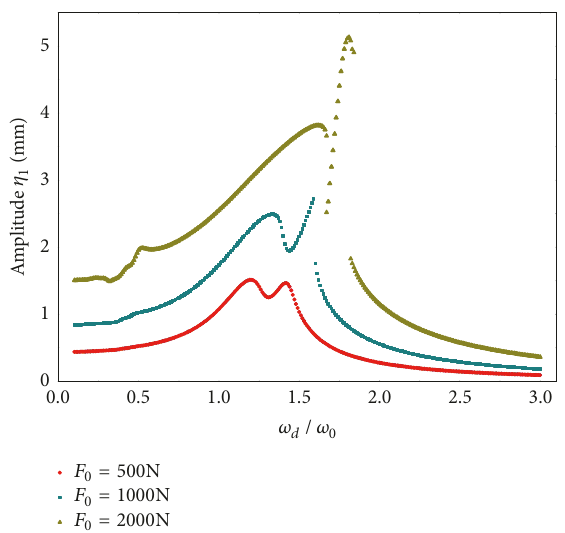
Figure 8: Amplitude-frequency curves related to 𝜂 1 for different excitation amplitudes ( 𝑚 = 1 , 𝑛 = 4 ; Ω = 0.005 ).